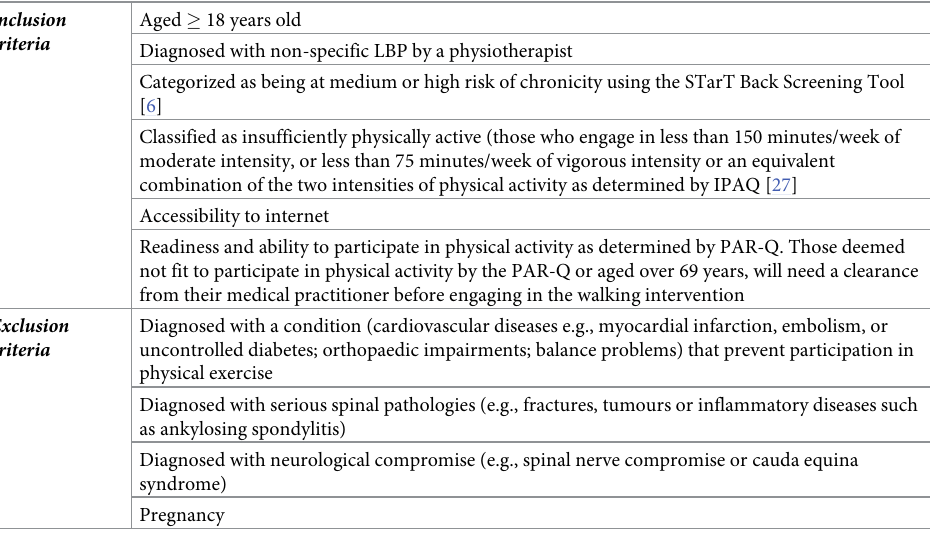
Table 1. Eligibility criteria for